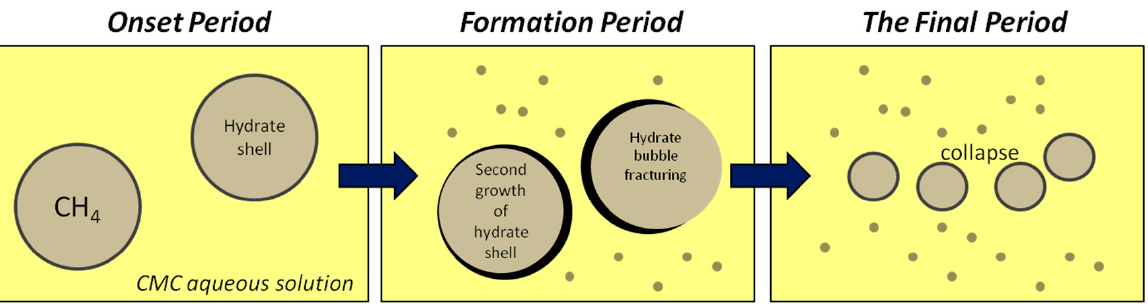
Figure 11. Scheme of the decomposition of the hydrate shell of a gas hydrate in the presence of Na-CMC.